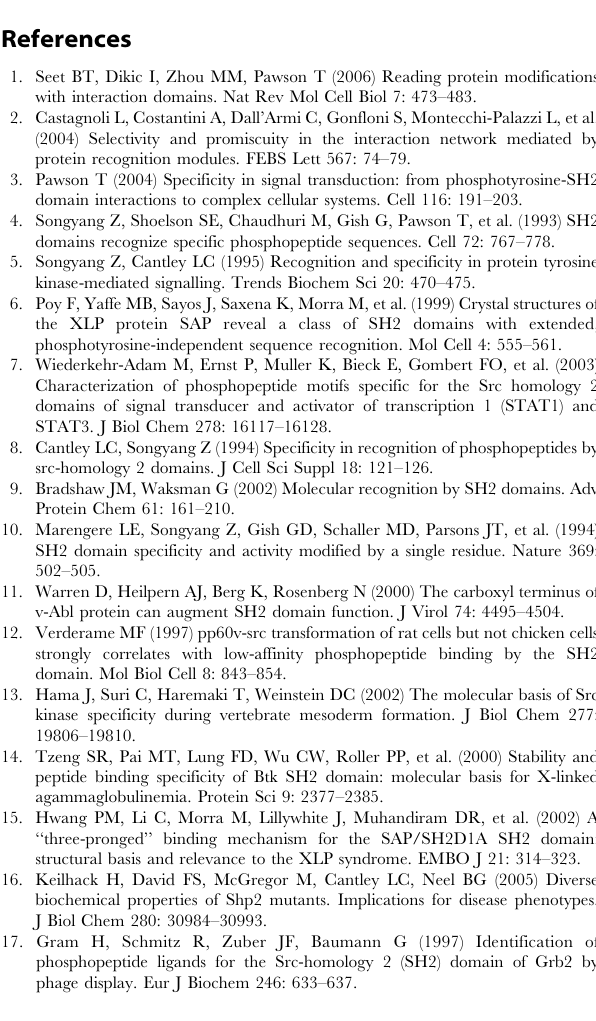
Table S5 Known SH2-mediated protein-protein interactions and binding sites in human. Table S6 High-confidence predictions of SH2-mediated pro- tein-protein